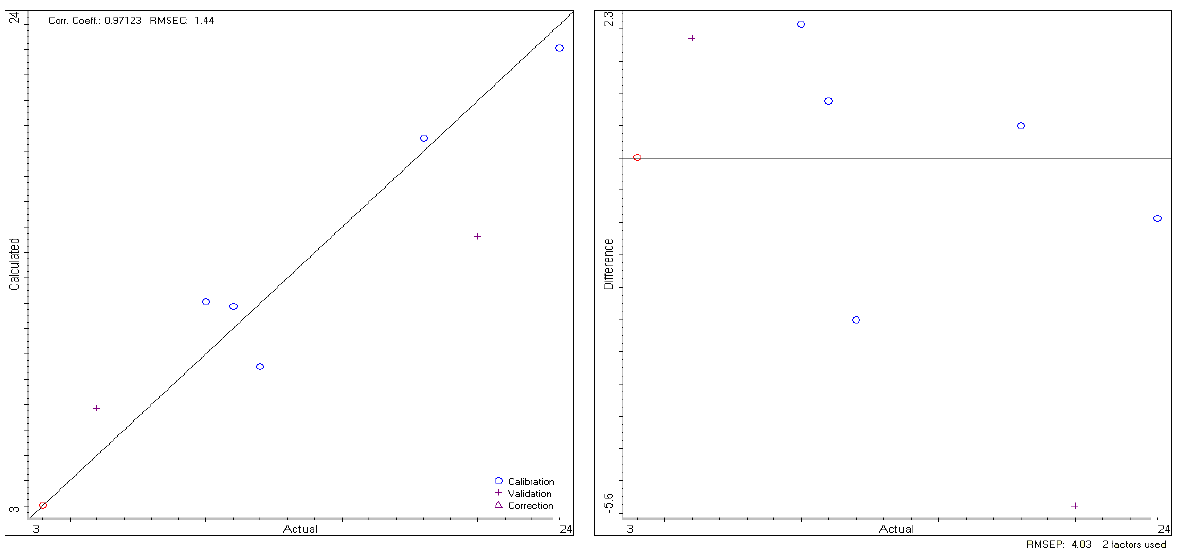
Figure 3. TQ Analyst software calibration and validation curves.